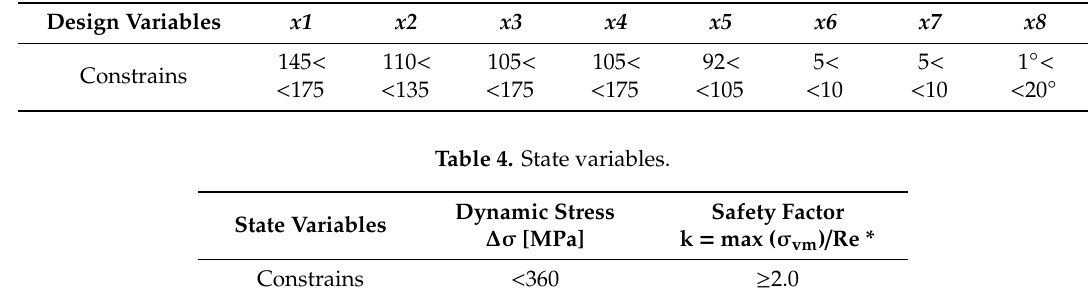
Table 3. Design variables (in mm).